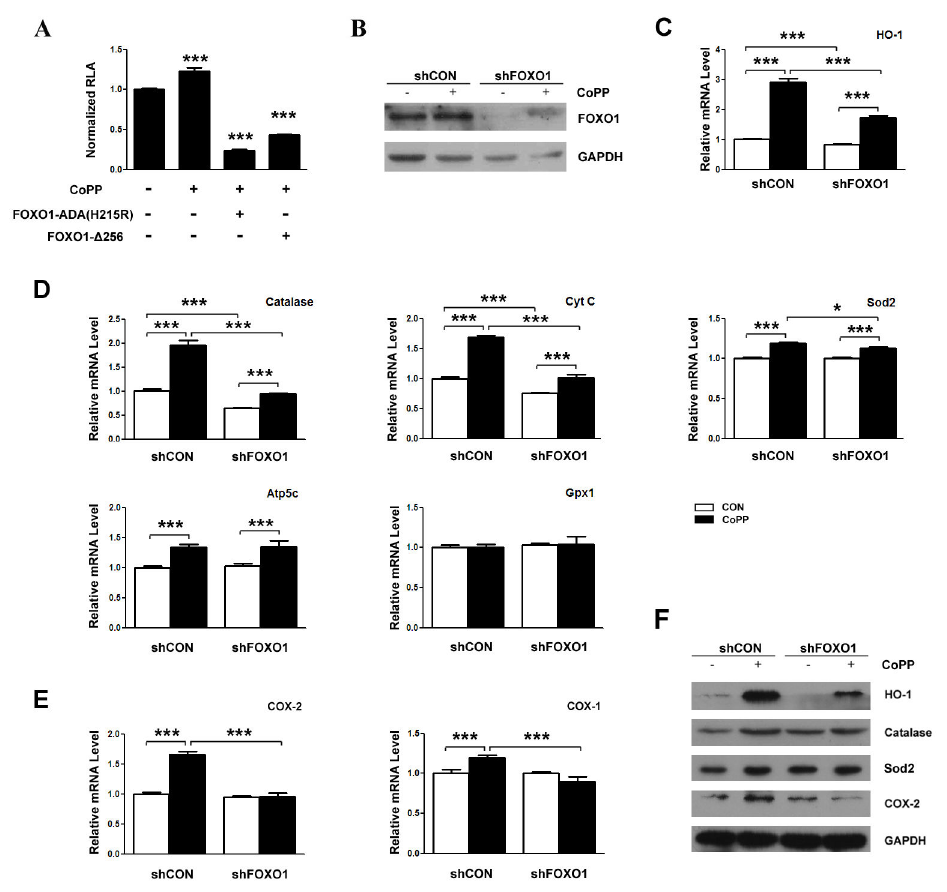
Figure 5. CoPP induced-expression of HO-1 and other oxidative stress-responsive genes are mediated partially by FOXO1. (A) FOXO1 mutants inhibit CoPP-induced HO-1 promoter transcription activity in HepG2 cells. HepG2 cells are co- transfected with pGL3-Basic-HO-1 promoter (200 ng) and the equivalent amounts of pcDNA3-FOXO1-ADA (H215R) ( pCMV5- FOXO1-Δ256 or control plasmids) as indicated, after which cells are treated with or without 10µM CoPP for 16 h. (B) FOXO1 expression is downregulated by shFOXO1. Primary hepatocytes are infected with shFOXO1 for 40 h, after which cells are harvested, total protein assays are carried out. (C, D, E) CoPP induced-expression of HO-1 and other oxidative stress-responsive genes are mediated partially by FOXO1. Primary hepatocytes are infected with shFOXO1 or shCON for 24 h before treatment for 16 h with and without 10µM CoPP, after which cells are harvested, total RNA assays are carried out. mRNA is quantified by qRT- polymerase chain reaction and relative amounts of mRNA are normalized to β-actin mRNA. (F) Primary hepatocytes are treated for 24 h with and without 10µM CoPP after infection with shFOXO1 or shCON for 24 h before, after which cells are harvested and total proteins assays are carried out. *p < 0.05, **p < 0.01and ***p <